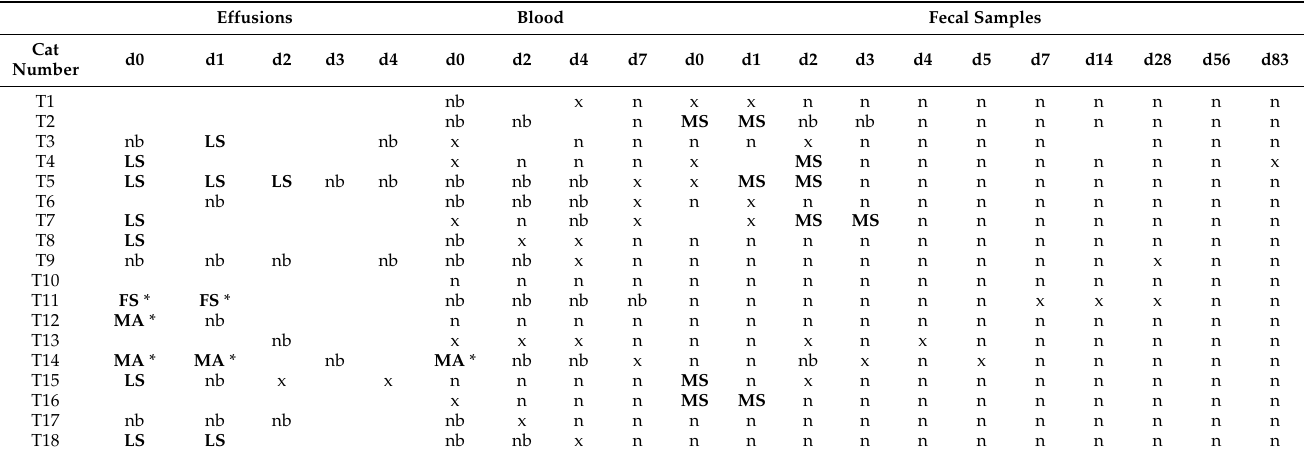
Bold: sequenced samples. LS: leucine at position 1058 and serine at position 1060; MS: methionine at position 1058 and serine at position 1060; FS: phenylalanine at position 1058 and serine at position 1060; MA: leucine at position 1058 and alanine at position 1060; nb: sample with no band detected after nested RT-PCR; x: FCoV RT-qPCR-positive but not sequenced due to low viral RNA load; n: FCoV RT-qPCR-negative sample; gray shading: no sample available. * Confirmed by cloning of the PCR amplicon and sequencing of several